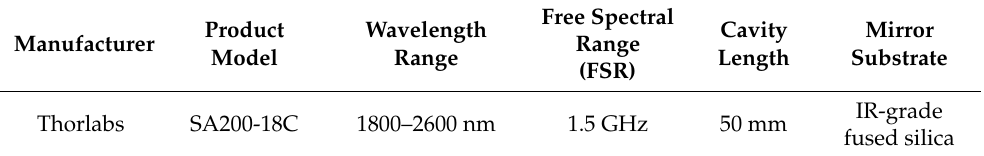
Figure 5. Schematic diagram of the sensing system used to validate 2f-SR. Table 2. The parameters of the etalon used in the experiment.